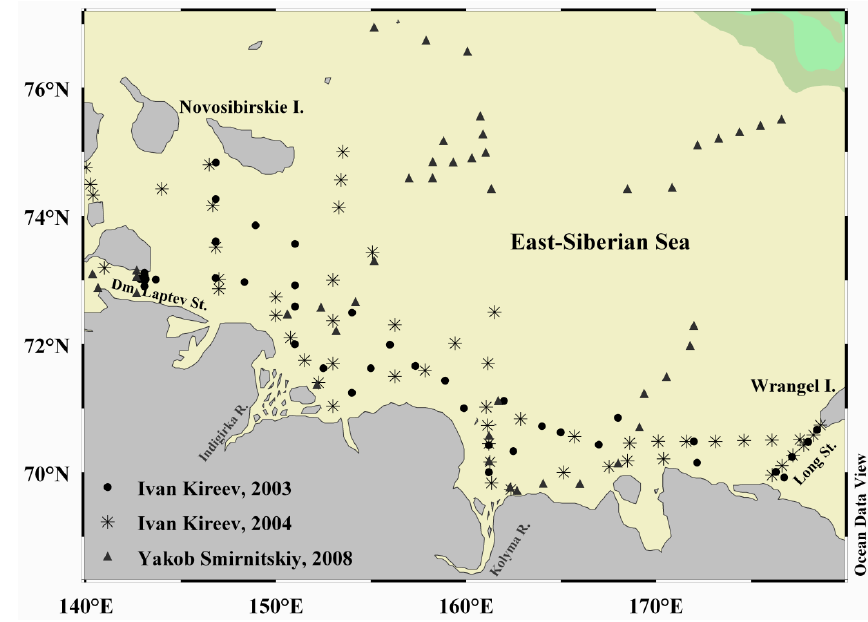
Fig. 2. Map of the stations in the East Siberian Sea during the 2003, 2004, and 2008